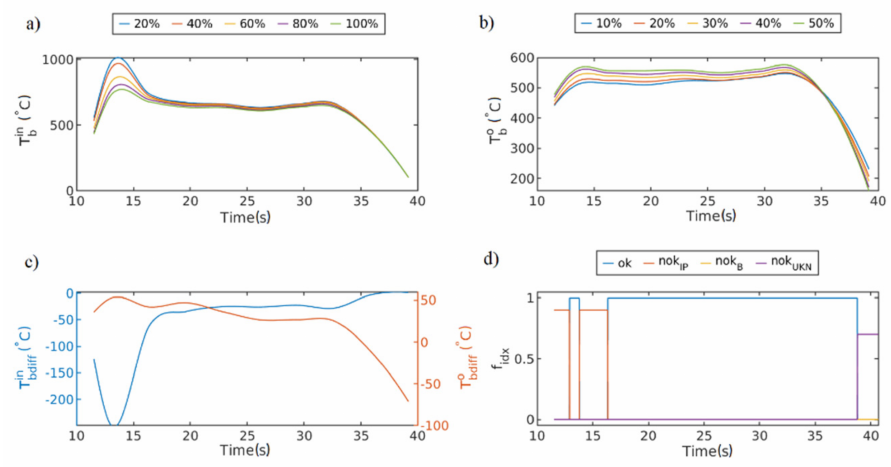
Figure 18. Feature and detection result for S13 using the interpolated IR sequence obtained using cubic interpolation with the interpolation factor = 196: ( a ) inner band temperature distribution T in ( b ) outer band temperature distribution T in detection result.